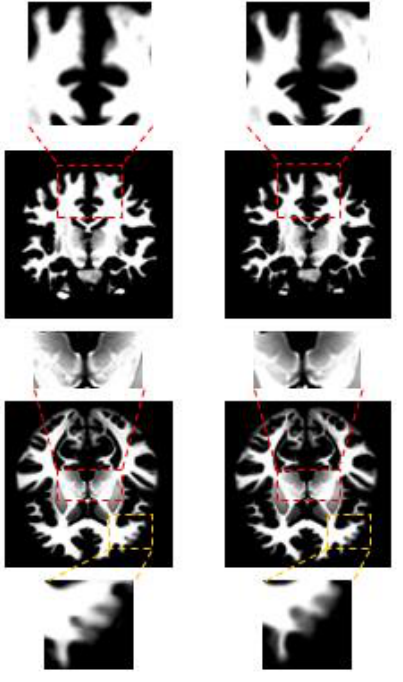
Figure 6. ROI boundary enhancement results on CIT168 and OASIS.